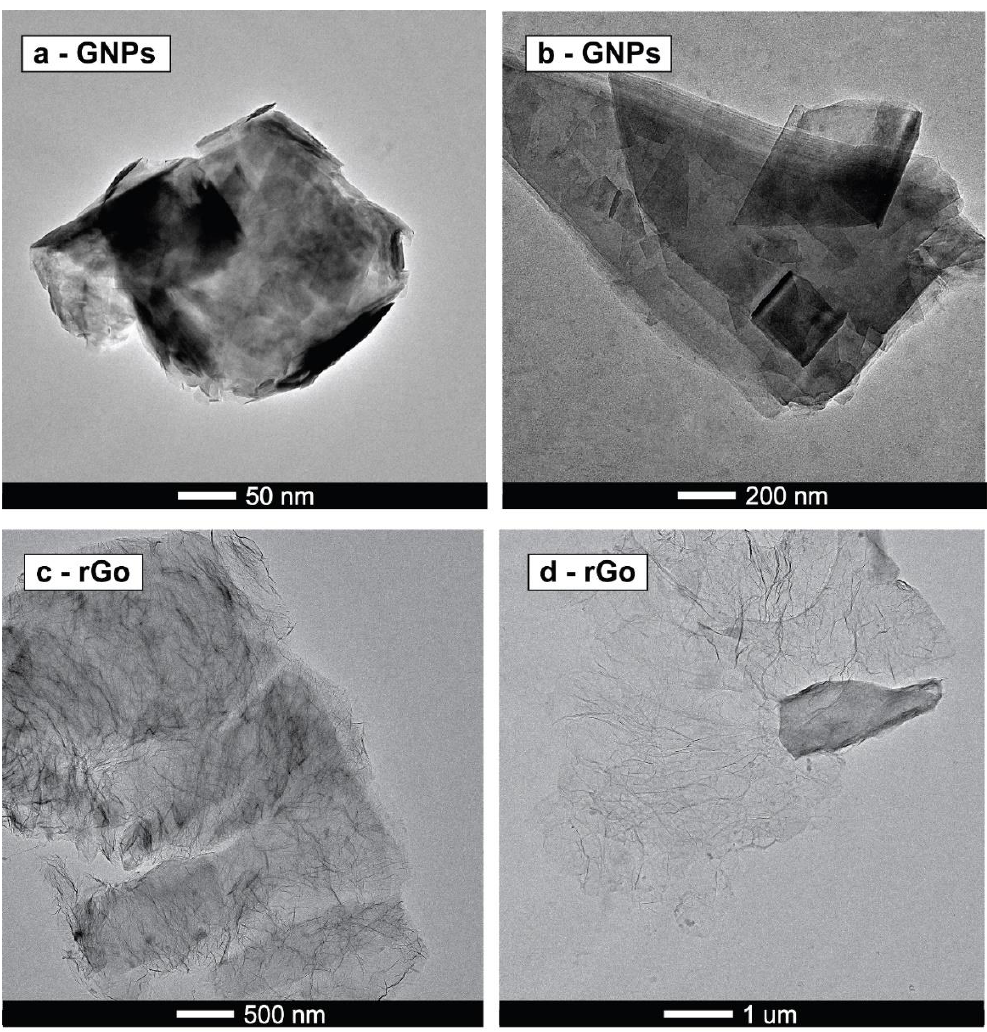
Figure 1. TEM graphs of nanoparticles: ( a , b ) GNPs and ( c , d ) rGO.